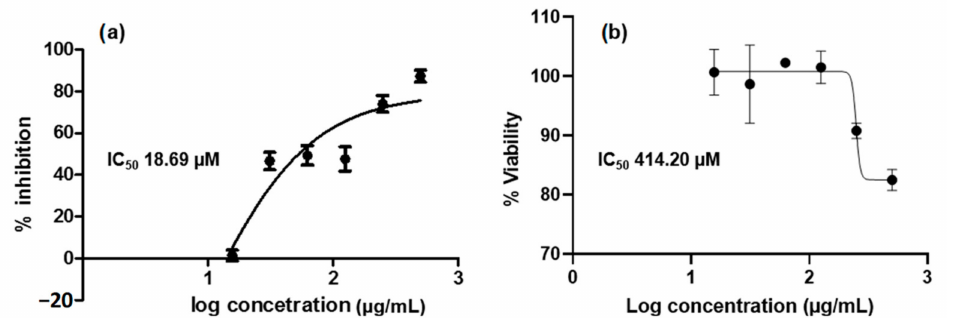
Figure 9. The drug-dose dependent curves of OTC against ( a ) MMP9 (IC 50 18.69 µ M; R 2 0.8099) and ( b ) 4T1 cells (IC 50 414.20 µ M; R 2 0.8473). NNGH was used as the positive control by showing IC 50 47.8 nM. The bars showed the standard error of triplicate assay as previously described.